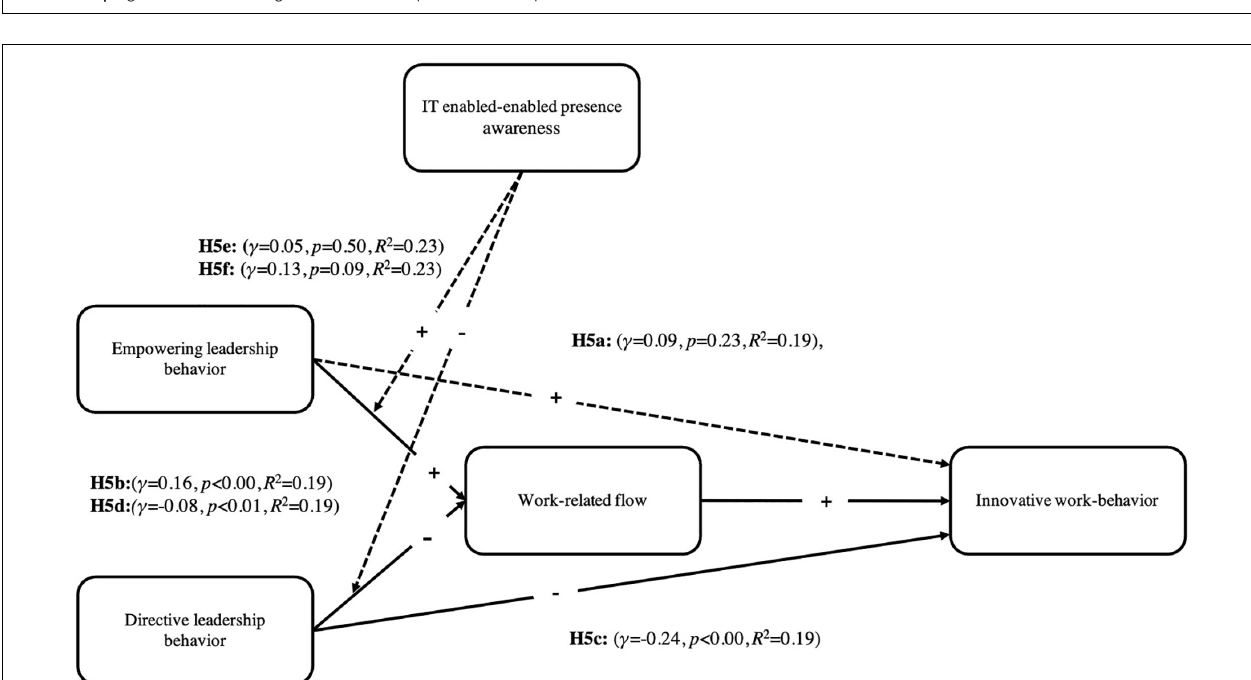
FIGURE 3 | Significant and non-significant relationships of the conceptual model in the second